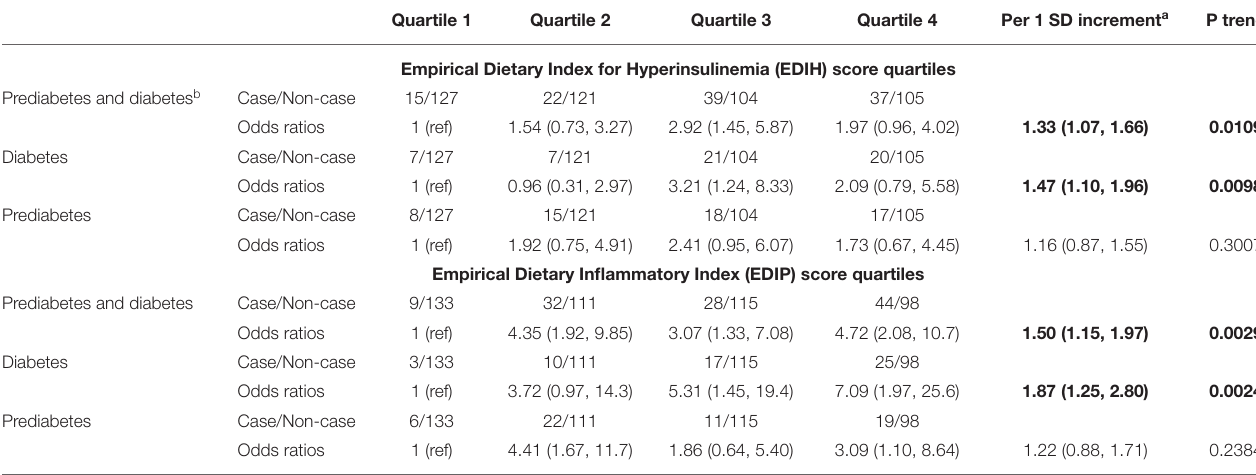
TABLE 3 | Odds ratios (95% CI) for the associations of diet indices with